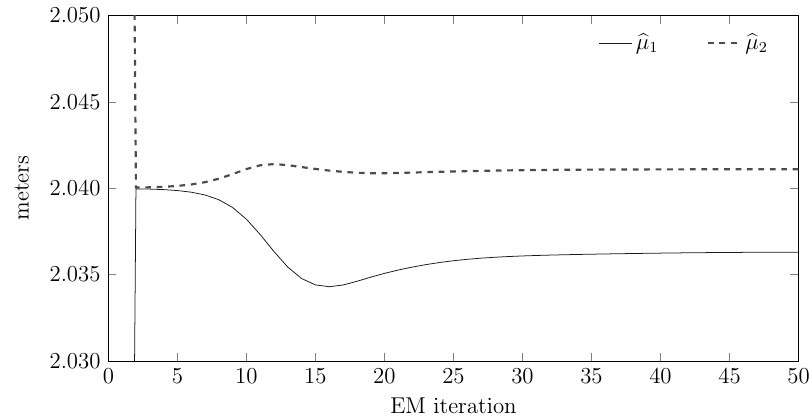
Figure 13. Convergence of the estimated means to their final estimates during the training phase for a training set containing 4000 raw measurements.